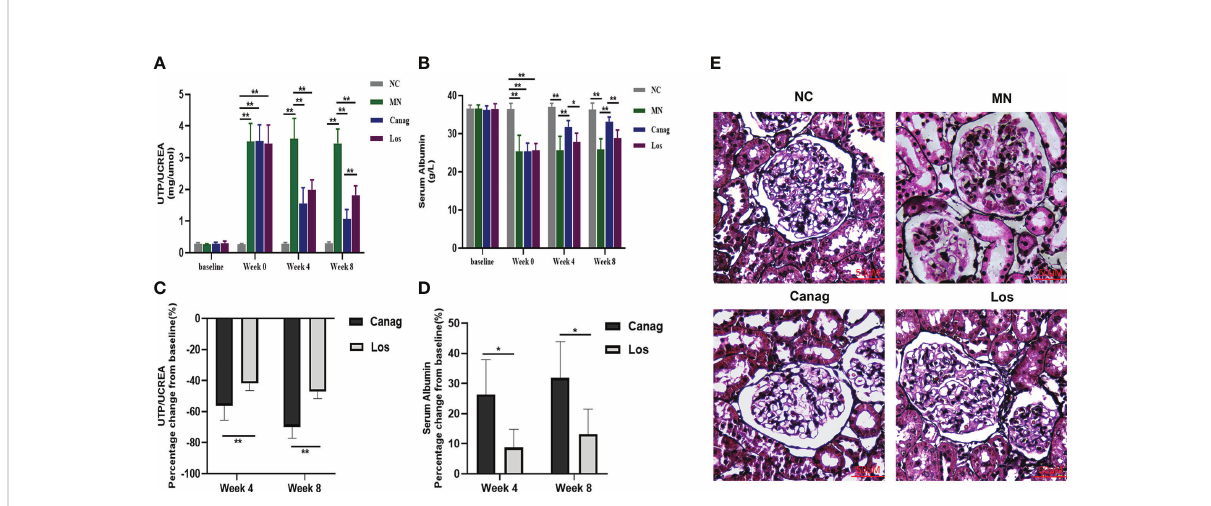
FIGURE 1 Canagli fl ozin improves the kidney disease of MN rats. (A, B) Urinary total protein/creatine and serum albumin at weeks 4 and 8 in membranous nephropathy rats treated with Canag and Los (n=6). Week 0 data refers to the data collected after modeling and before treatment. (C, D) Percentage change in urinary protein/creatine and serum albumin from baseline. (E) Representative PASM images of glomeruli. Scale bar, 50 m m. Data are shown as mean ± SEM values. The Student ’ s t test was employed to evaluate the signi fi cant difference between the two independent groups. One-way ANOVA followed by Tukey ’ s test for multiple comparisons was used. *P < 0.05, **P <